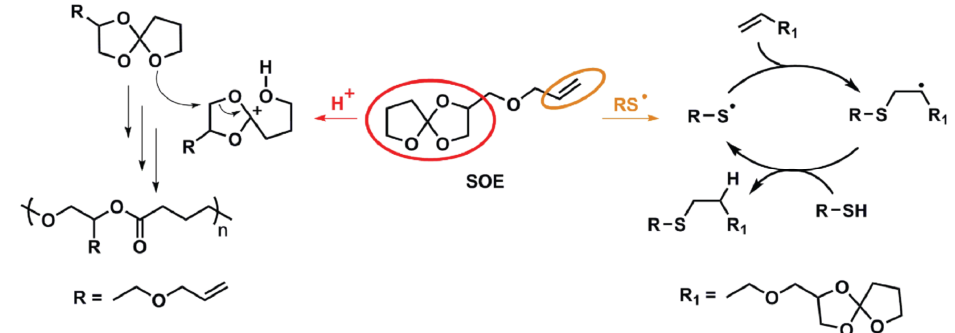
Figure 6. Mechanism of the cationic double ring-opening and the thiol-ene reaction of the spiroorthoester (SOE). Reproduced from [55] with permission from Wiley.